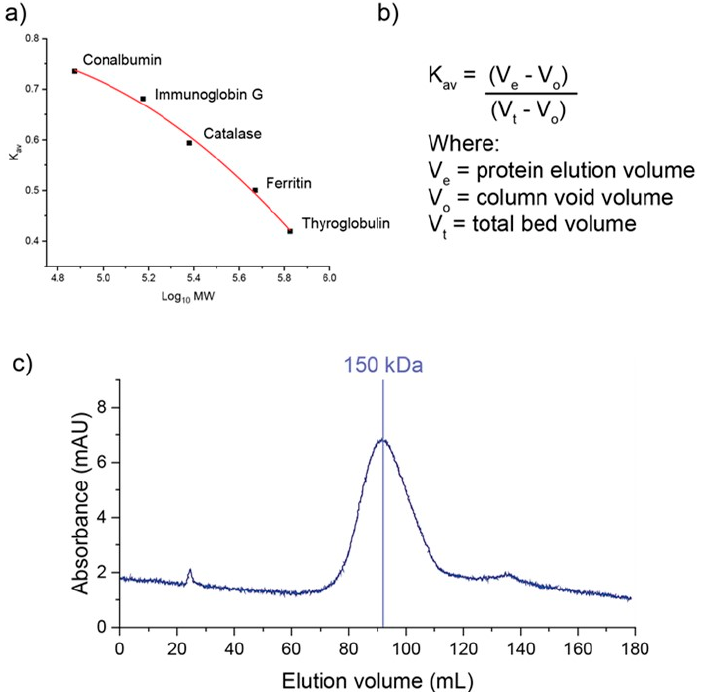
Figure 7. Example of MW determination using gel filtration chromatography. Samples were loaded on a HiPrep 16/60 Sephacryl S-400 HR column and run at 0.75 mL/min in 100 mM sodium phosphate buffer (pH 7.4) containing 150mM NaCl. Image ( a ) shows the commercially available standards are run on the column, and the K av is plotted against the log of MW for each standard. ( b ) The K av (distribution coefficient) is calculated using the elution volume of the protein, the column void volume (e.g., determined using blue dextran), and the total bed volume, which is calculated based on the column internal diameter and height. ( c ) The dissolved fibroin sample in buffer is run on the column, and the peak elution volume is used to determine the K av ; this value is then used with the standard curve to determine the MW of the sample (in this case, 150 kDa).